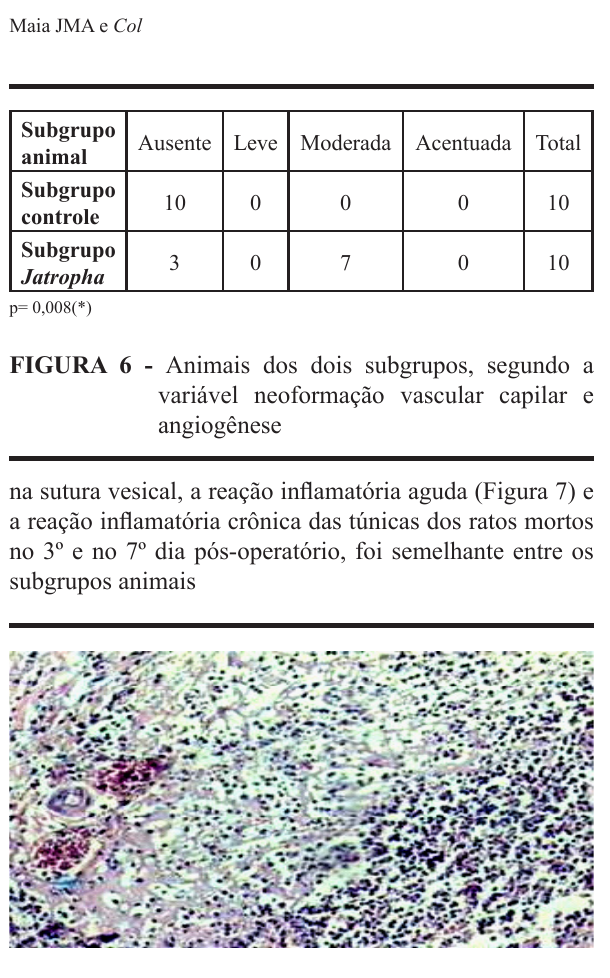
FIGURA 7 - Fotomicrografia com área de inflamação aguda, edema, infiltrado neutrofílico e congestão (subgrupo Jatropha , coloração H.E., aumento 100x). Nota: Área com infiltrado inflamatório agudo (seta)